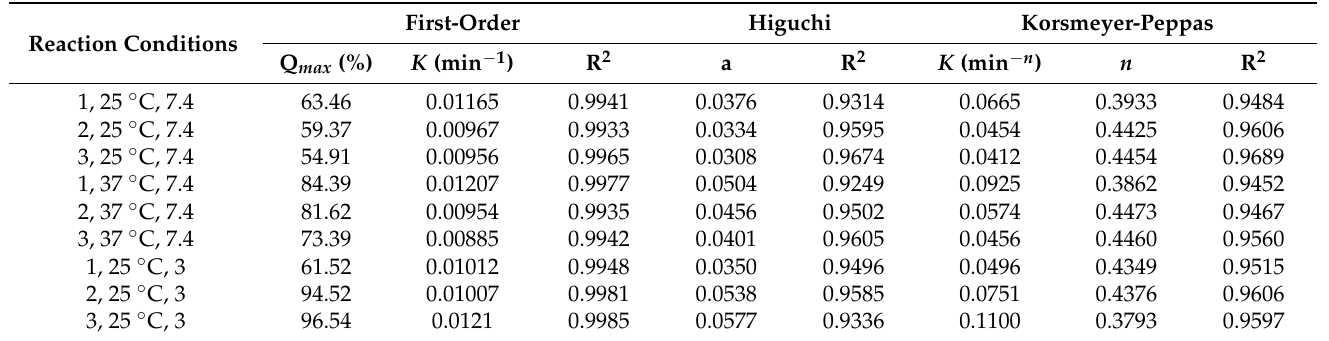
Table 3. Release kinetics for 5-FU-loaded aerogels under different